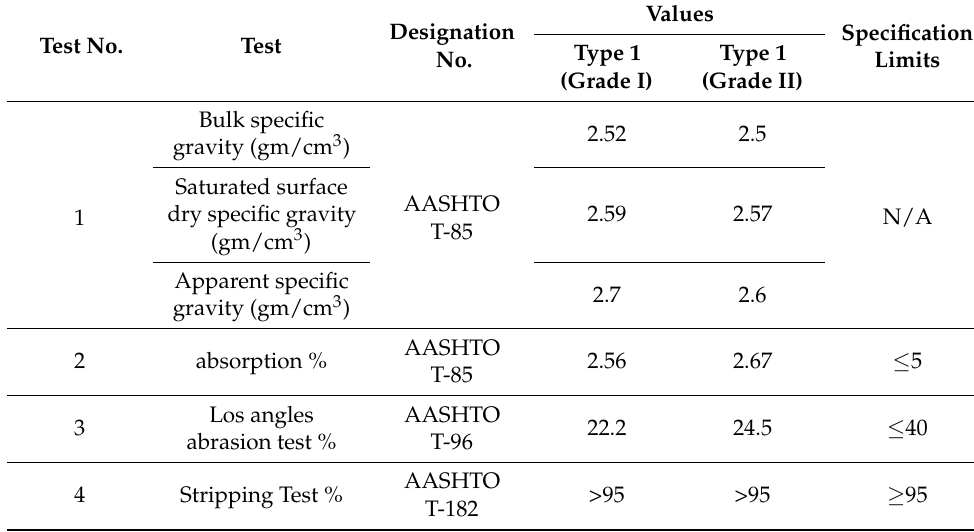
Table 1. Properties of coarse aggregate.